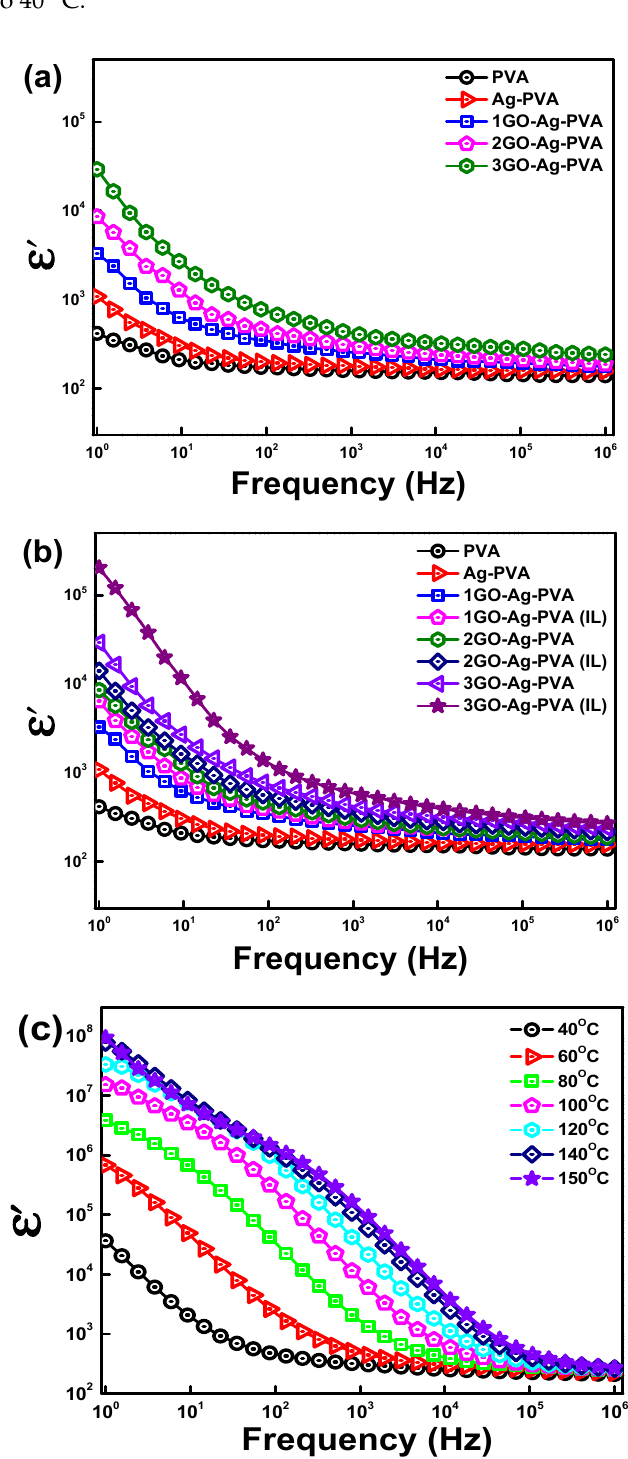
Figure 4. Dielectric permittivity of GO-Ag-PVA nanocomposites as a function of ( a ) GO loading, ( b ) ionic liquid and ( c ) temperature effect on 3GO-Ag-PVA (IL).